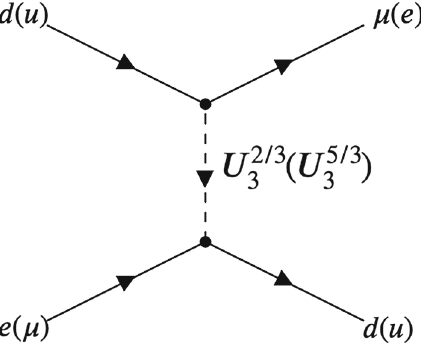
Fig. 2 Feynman diagram for the decay of π 0 → μ ± e ∓ through the exchange of U 3